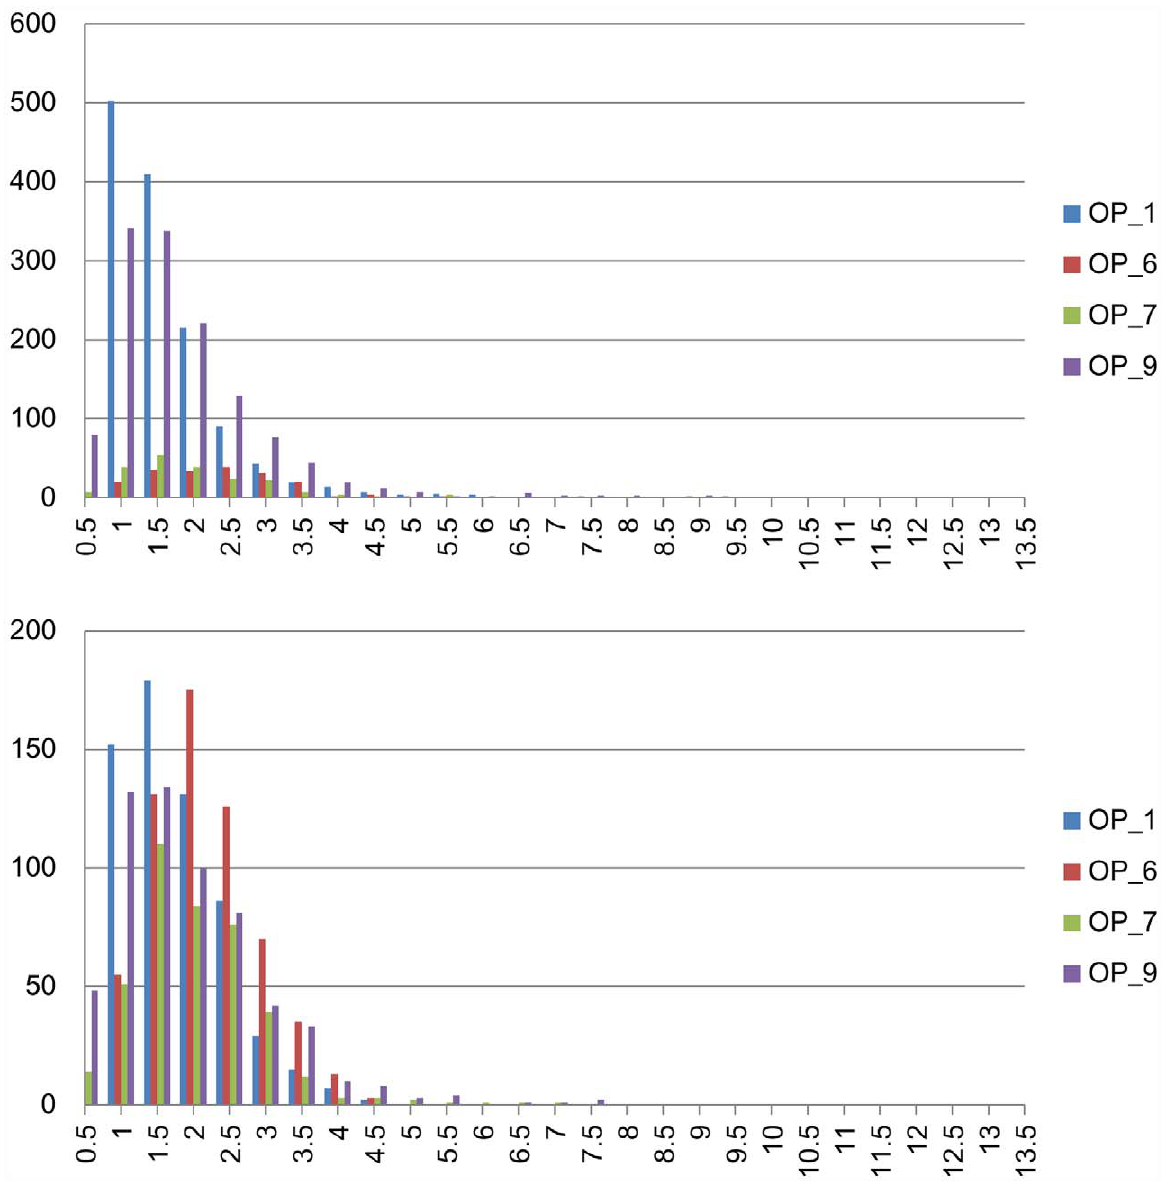
Figure 4. These two histograms show the distribution of the distances between points on one reconstructed result and a reference reconstruction. The references are respectively our reconstruction (top) and the ground truth (bottom).